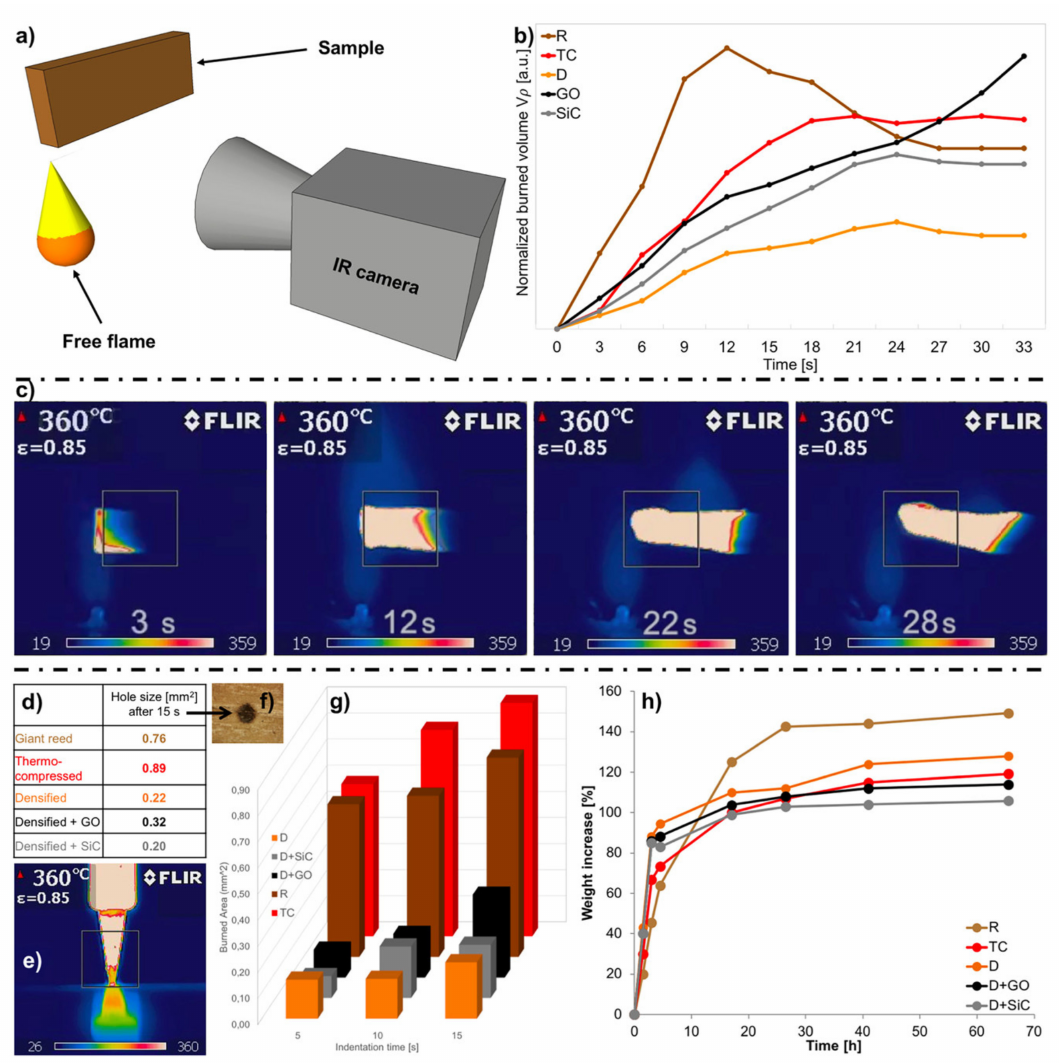
Figure 4. ( a ) Schematic representation of the burning test setup. ( b ) Burning test results of all specimen types. ( c ) Time evolution of thermal imaging data from D + GO sample (complete videos are available in SI). ( d ) Table showing the burned area after the 15 s of thermo-indentation ( e ) thermographic image of the indenter tip ( f ) burned area results of all specimens when subjected to 5, 10, and 15 s of thermo-indentation ( g ) burned area vs. indentation time. ( h ) Accelerated humidity absorption tests carried out on R, TC, D, D + GO, and D + SiC specimens. The graph represents the weight increase of samples vs. exposition time at constant 97% of relative